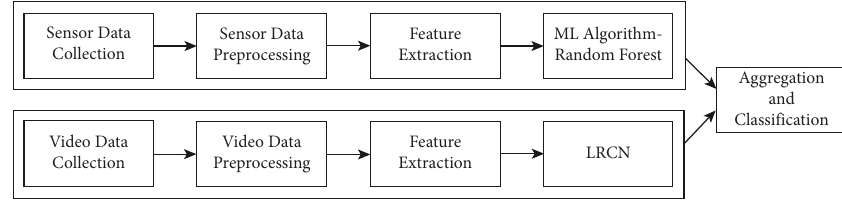
Figure 5: Proposed multimodel fall detection